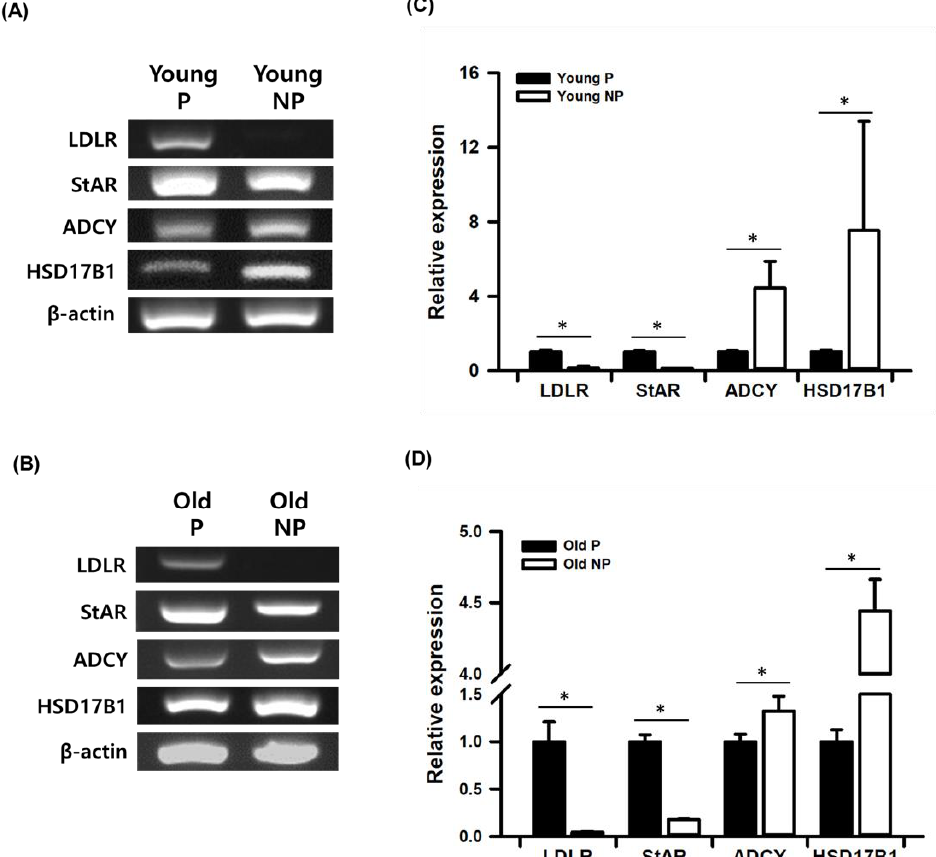
Figure 4. Validation of transcriptome data by RT-PCR. Up- and downregulation of genes were confirmed for LDLR, StAR, ADCY, and HSD17B1; β-Actin was used as a control. Gel images of PCR products are shown for the young ( A ) and old ( B ) pregnancy and non-pregnancy groups. ( C , D ) Data of real-time RT-qPCR for up- and downregulated genes, based on NGS data from the pregnancy and non-pregnancy groups. Data are presented as means ± SEM of three replicates. Significant differences are indicated by asterisks (* p < 0.05).